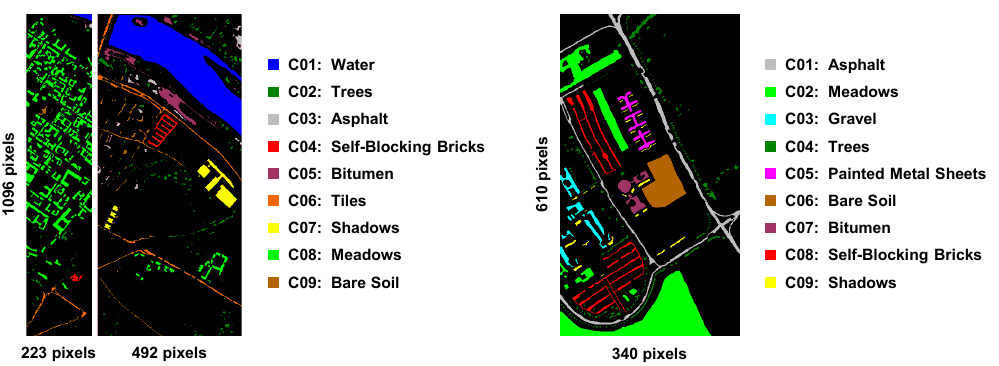
Figure 2. Reference labels for the Pavia Centre dataset ( left ) and for the Pavia University dataset ( right ): each pixel is characterized by reflectance values on 102 spectral bands and 103 spectral bands, respectively. Unlabeled pixels are indicated in black.